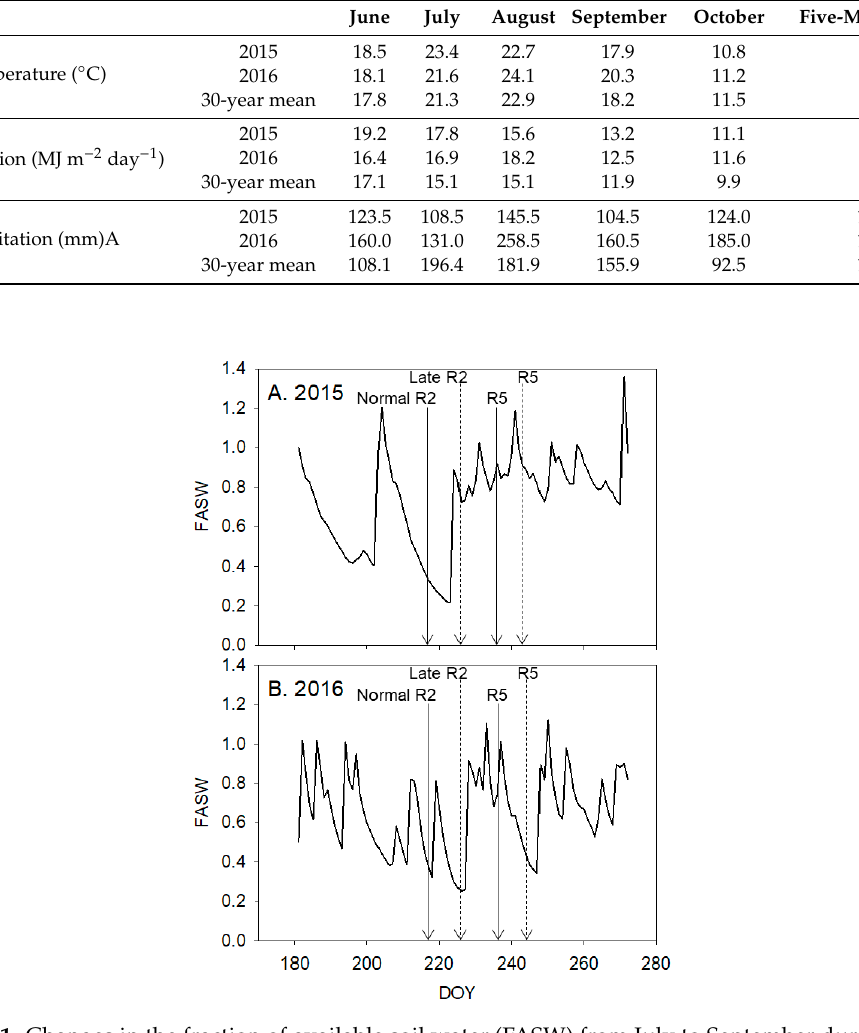
Figure 1. Changes in the fraction of available soil water (FASW) from July to September during the soybean growing season in ( A ) 2015 and ( B ) 2016 in the Tohoku region of northern Japan. DOY, day of the year. R2, beginning of flowering; R5, beginning of seed filling stage; | normal sowing date; ⁞ late sowing date; arrows indicate means of the three cultivars.